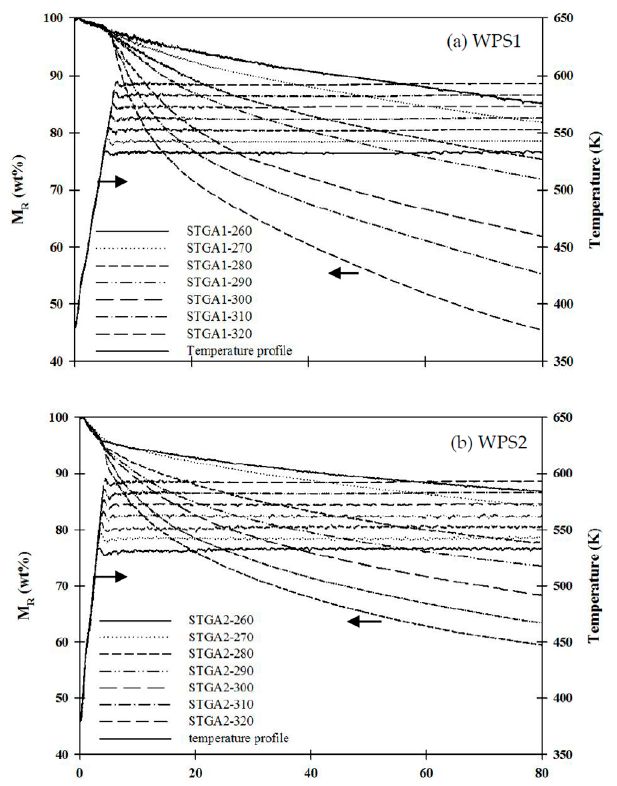
Figure 3. Simulated torrefaction of ( a ) WPS1 and ( b ) WPS2 via TGA at different setting temperatures. STGA1-260 and STGA2-260: torrefaction of WPS1 and WPS2 via TGA at 260 ◦ C, respectively. t T : torrefaction time.